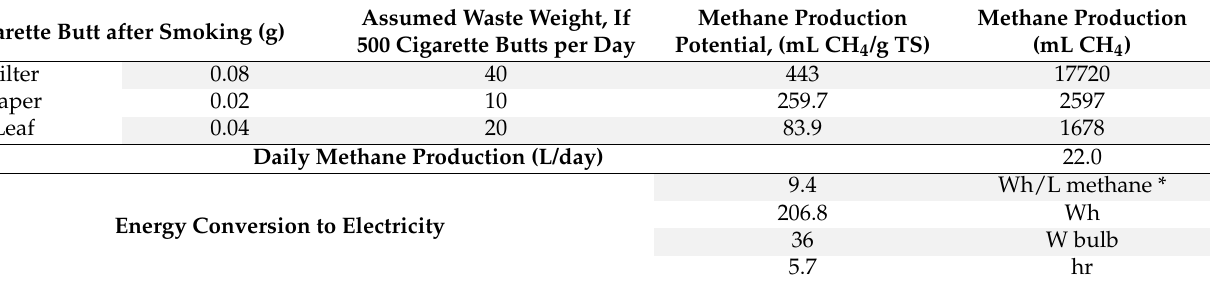
Assumed Waste Weight, If Methane Production Methane Production 500 Cigarette Butts per Day Potential, (mL CH 4 /g TS)